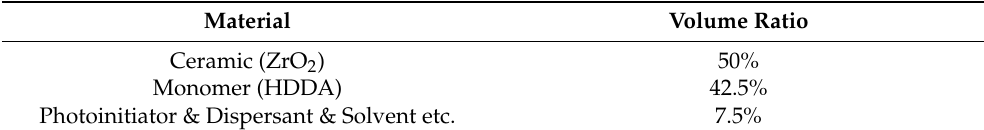
Table 2. Compositions of ceramic composite resin.